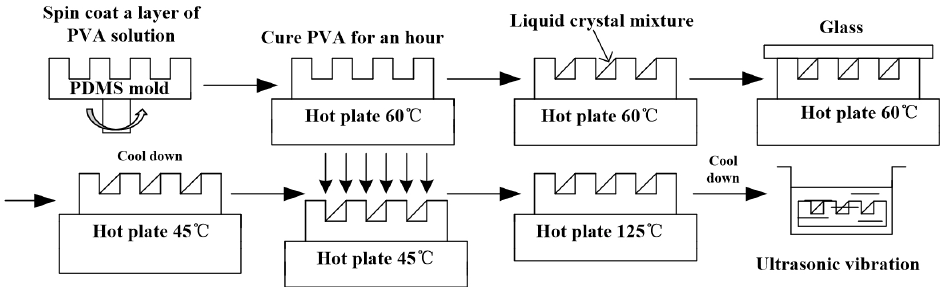
Figure 3. Fabrication process of polymer cholesteric liquid crystals (PCLC) flakes using soft